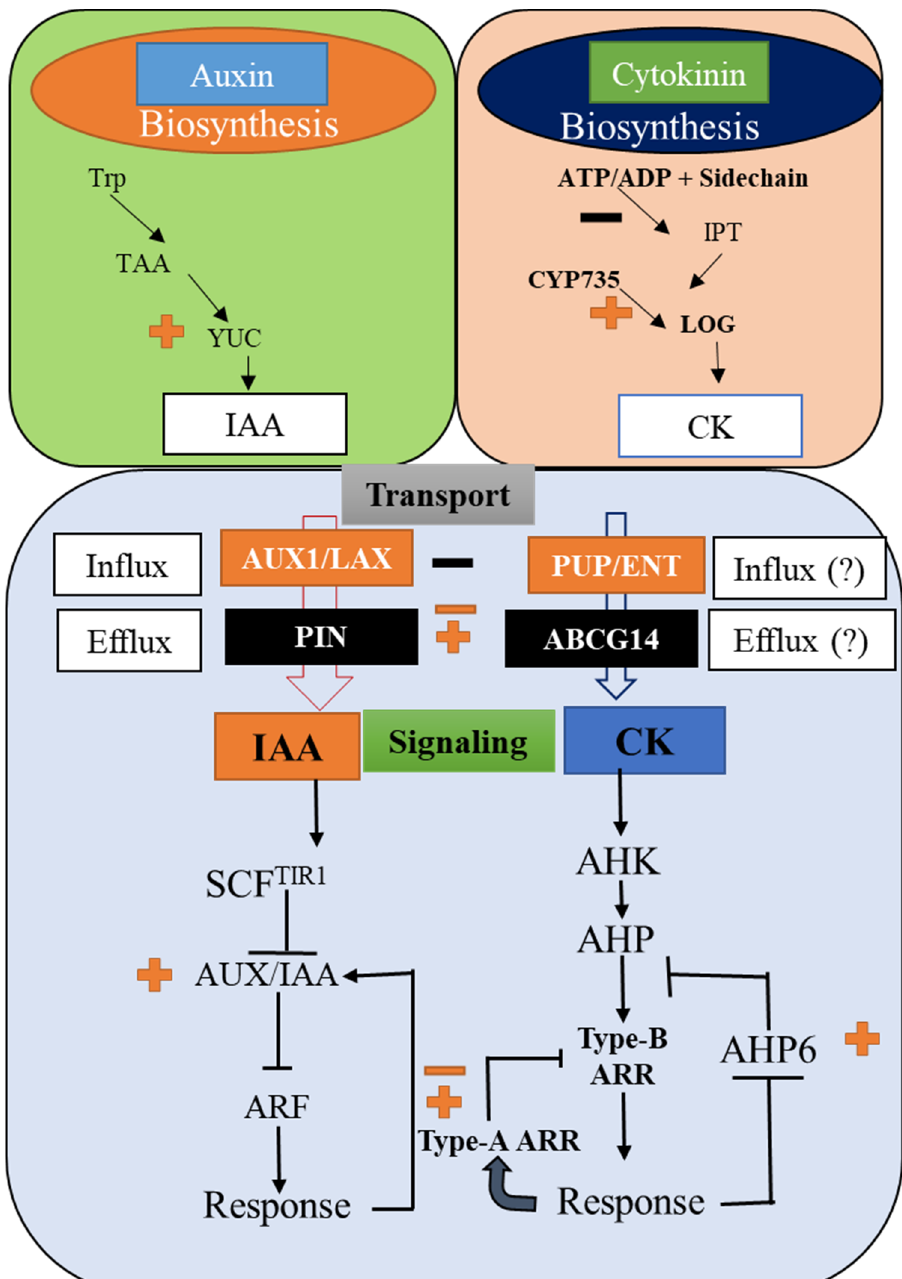
Figure 1. A schematic diagram depicting the biosynthesis, transport, and signaling of auxin and cytokinin in plants. Solid lines represent the established regulatory connections, whereas the dashed line indicates the possible connection. Line ending with a crossed line indicates the negative regulations.